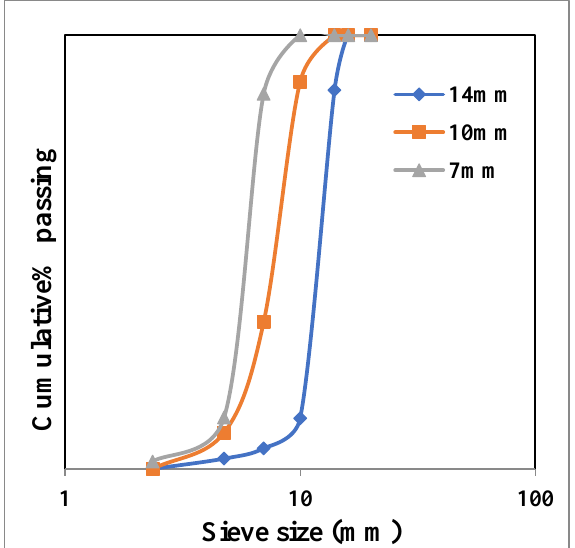
Figure 2. Grading curve of coarse aggregate.